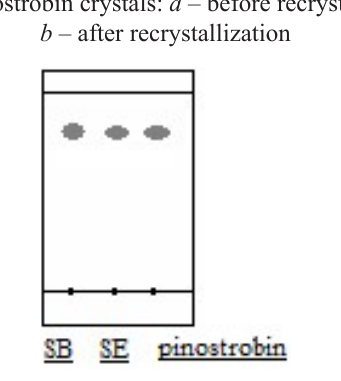
Fig. 4. Thin-layer chromatography of crystals obtained from the substance (SB), (SE) with a pinostrobin marker